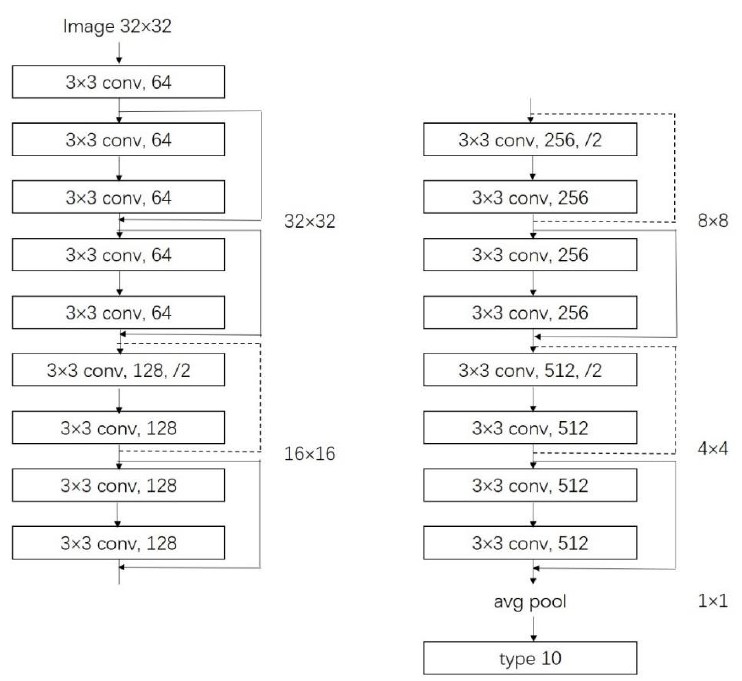
Figure 5. ResNet for transferring.